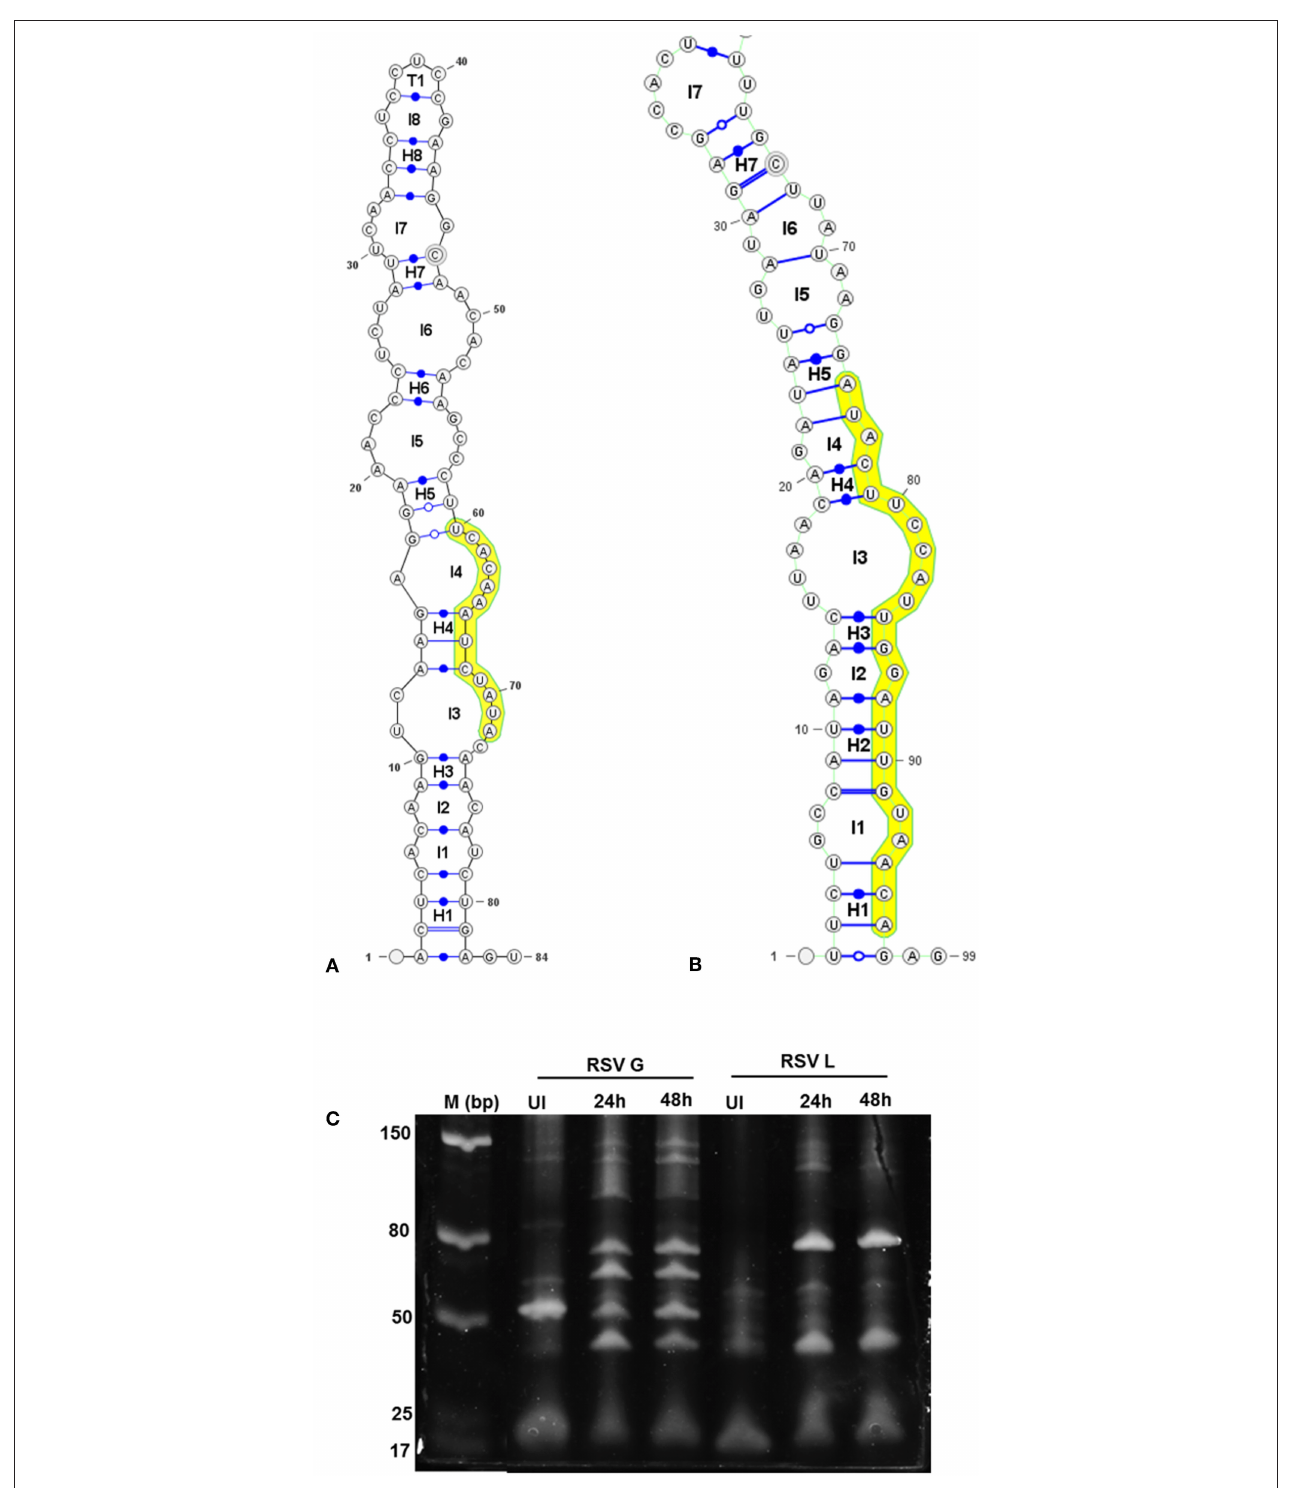
FIGURE 4 | Viral genomic regions form characteristic stem- loop folds in vSM and vSS encoding regions and are processed into smaller transcripts. Secondary structures of a 100 nt sequence flanking vSM-4719 (A) and − 556-3p (B) were predicted using RNAfold and drawn using VARNA. Highlighted region corresponds to the vSM. Internal and terminal loops are prefixed with L and T, respectively. Helices are prefixed with H and the 5 ′ and 3 ′ ends of the molecule are as indicated. (C) Size-fractionated small RNA from mock or RSV A2 infected (24h or 48h pi) Vero cells was reverse transcribed using RSV G- and L-specific reverse primers. Amplicons obtained using a G/L specific primer pair were electrophoresed on a 12% PAGE gel alongside a molecular ladder and stained with SYBR gold.